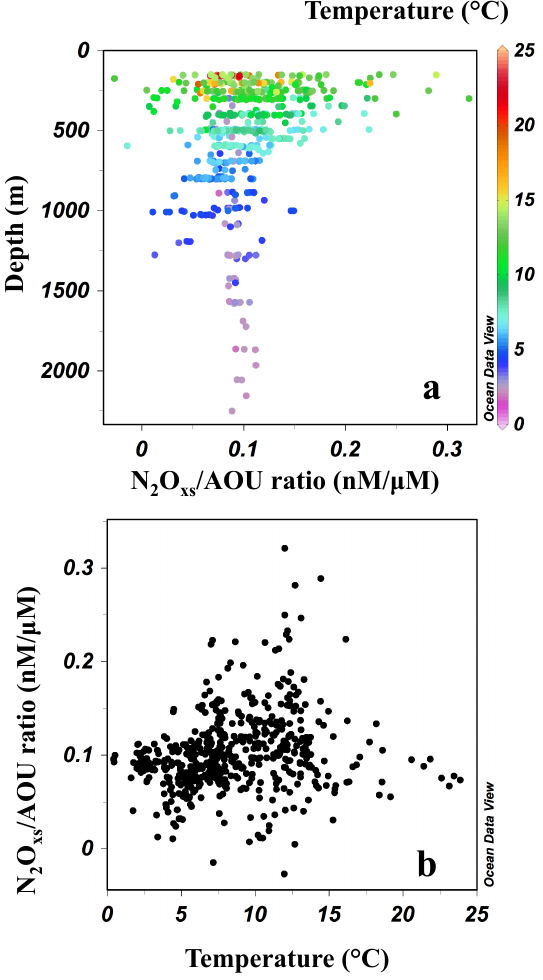
Fig. 8. O 2 -corrected N 2 O xs /AOU ratios (nM/µM) vs. depth (m) and temperature ( ◦ C) for MEMENTO profiles shown in Fig. 2. O 2 dependency was corrected for by the linear relationship shown in Fig. 5, standardised to a fixed level of 276µM O 2 , the highest O 2 concentration observed in the selected data. Samples likely to be influenced by denitrification were excluded (see Sect. 2.3 for exclu- sion criteria). Note: in order to show detail, two outliers with high N 2 O xs /AOU ratios were excluded in the figures